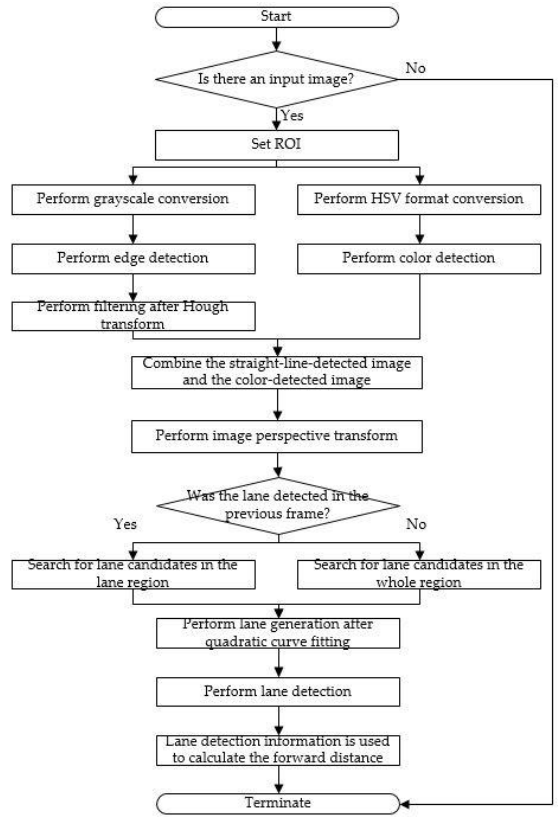
Figure 1. Flowchart of lane detection algorithm.